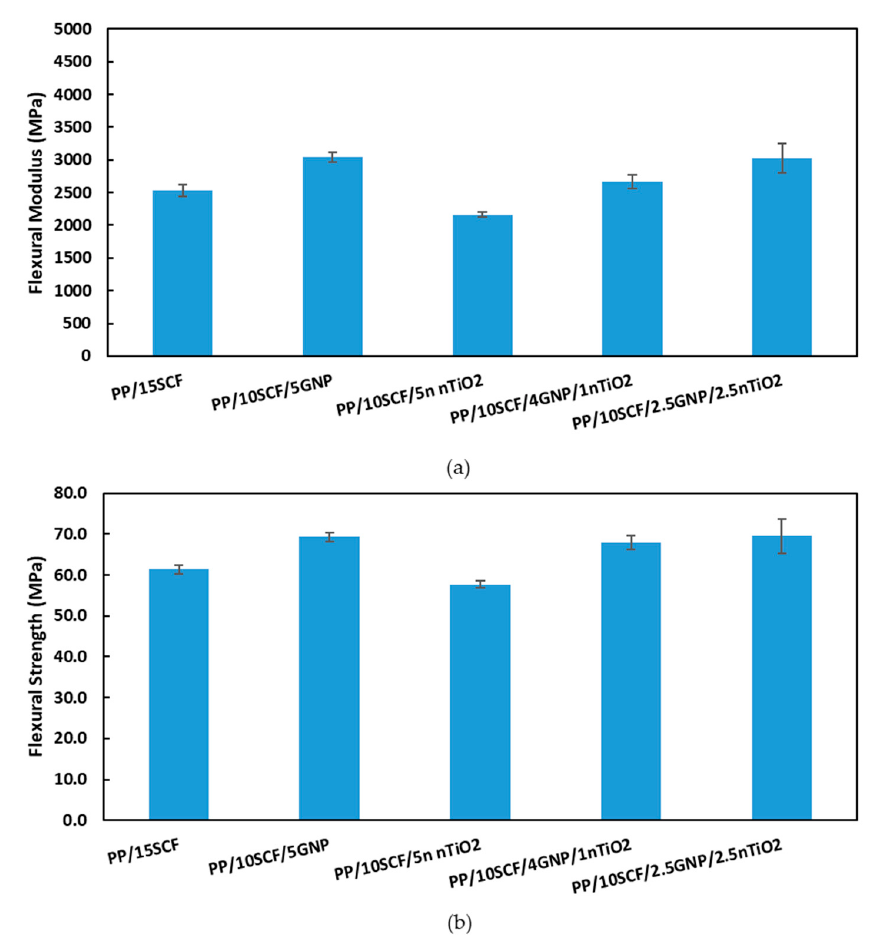
Figure 13. ( a ) Flexural modulus and ( b ) flexural strength at 15% loading for different composites.